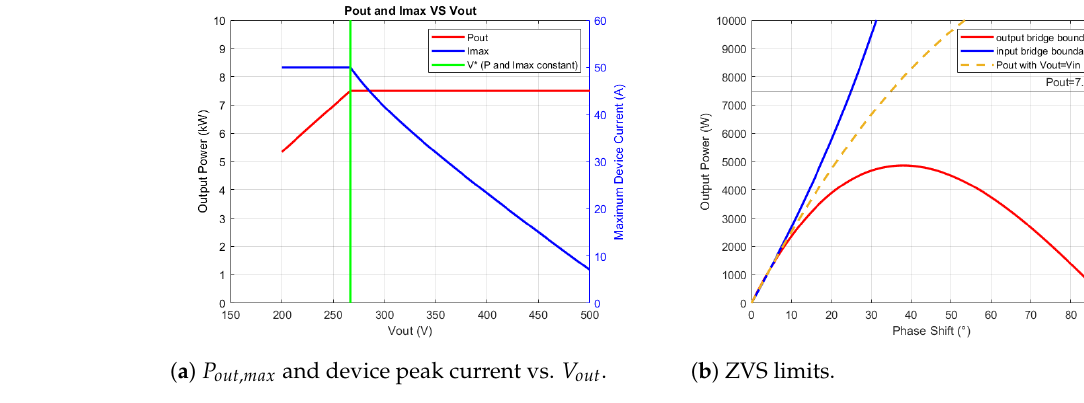
Figure 5. Design